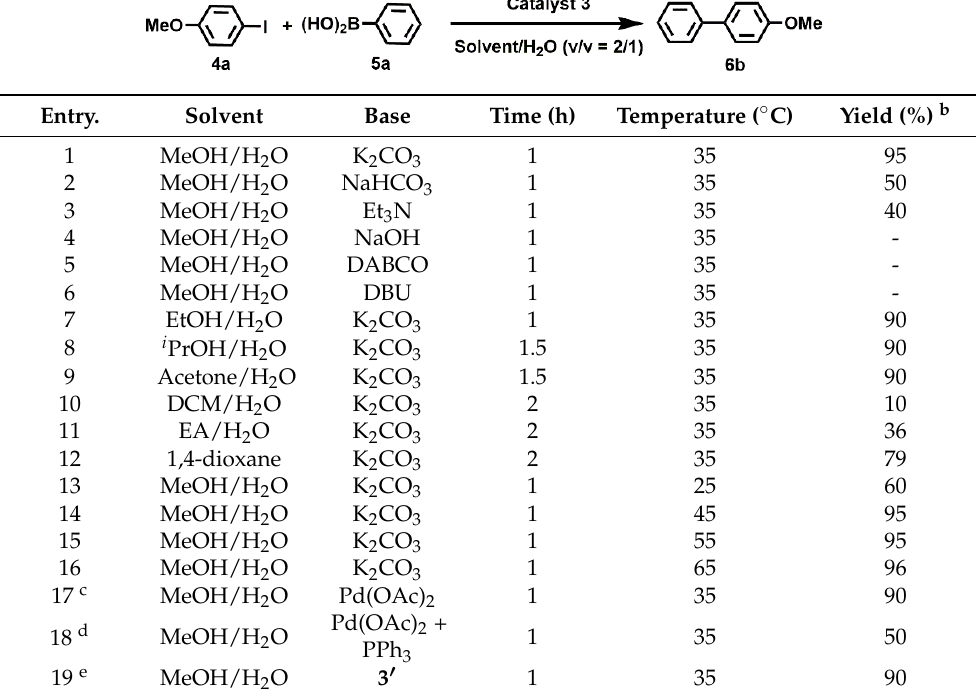
Table 1. Optimization of reaction conditions a .